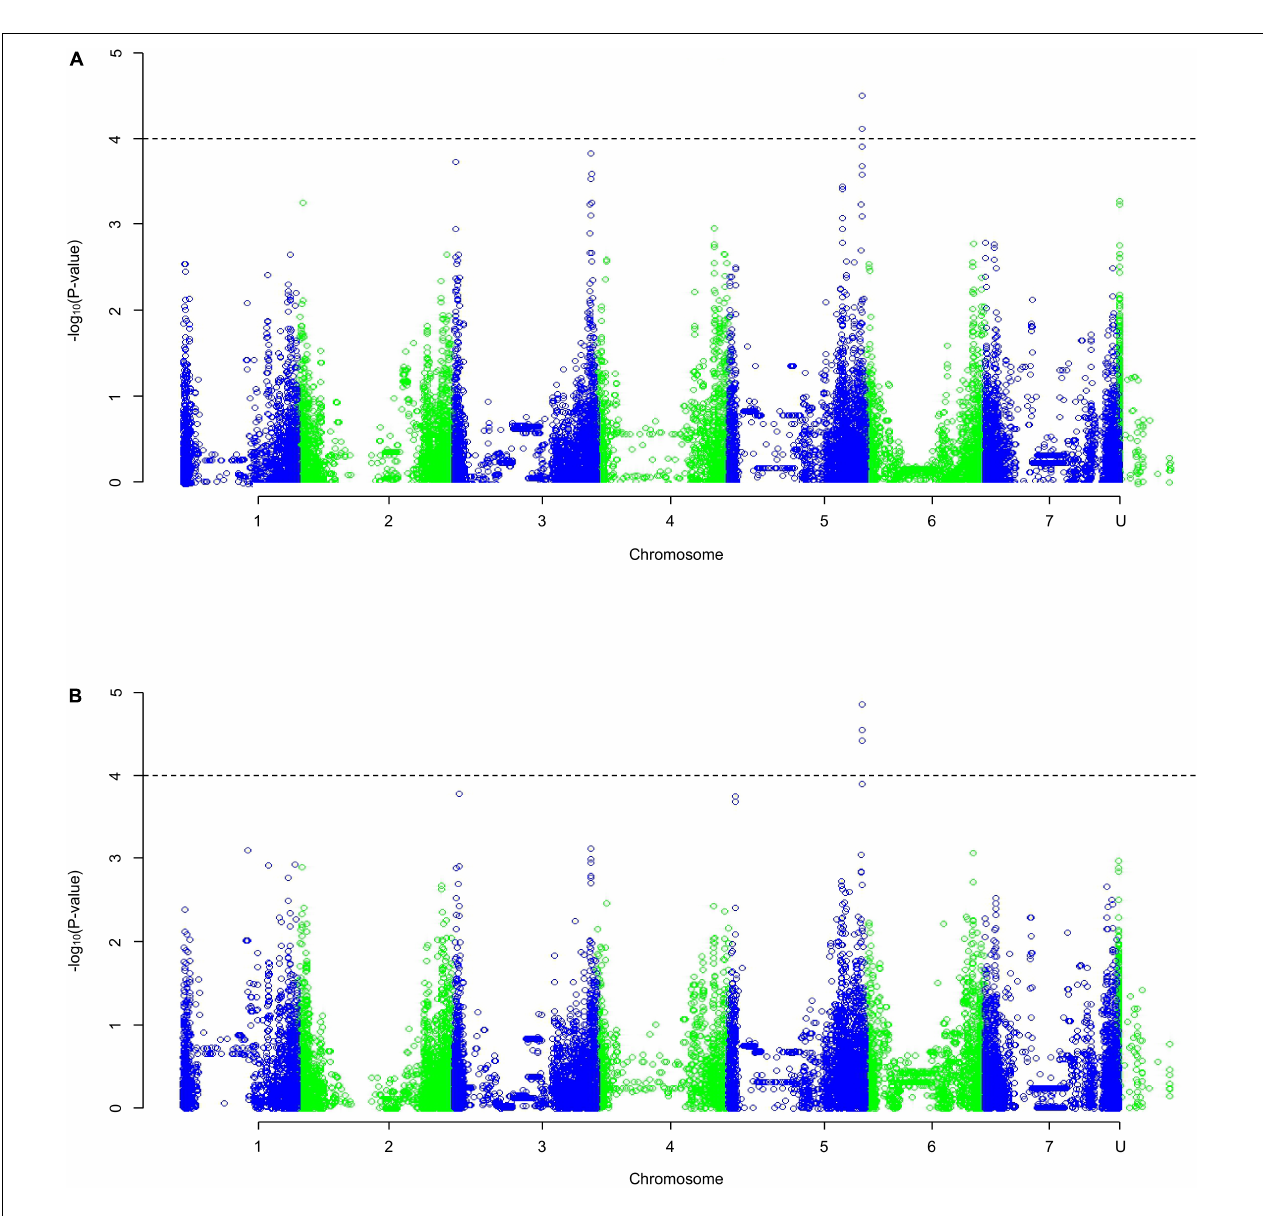
FIGURE 3 | A Manhattan plot of a Genome-Wide Association Study undertaken using a Mixed Linear Model on the average change in dry weight with increasing salt concentration as (A) weight, (B) percentage of the average control weight; data generated using an ANOVA. Depressions in marker significance observed in the center of each chromosome are due to reduced marker density around the centromere of the physical